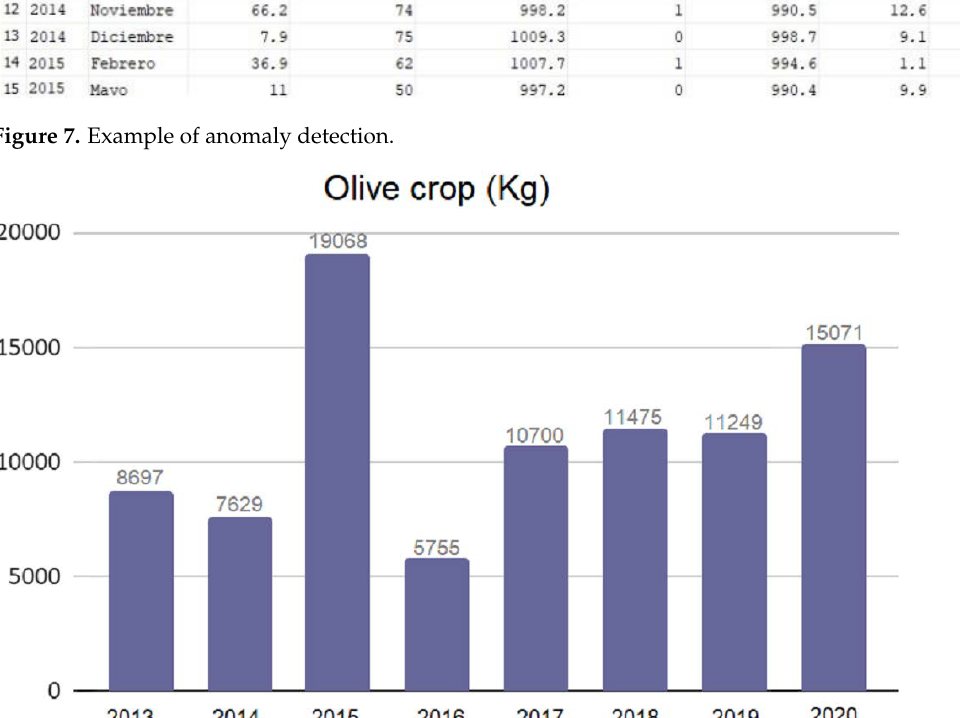
Figure 8 . Yield data history of the farm under study. 3.2. Variables Influencing Olive Crop Prediction